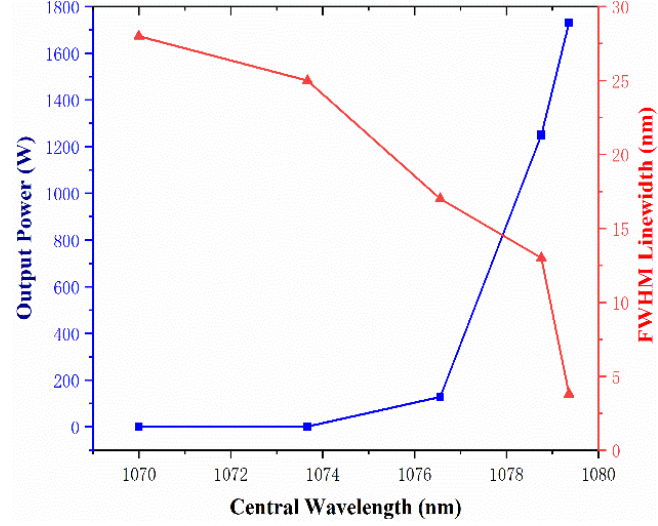
Figure 4. Variation trend of output power and FWHM.